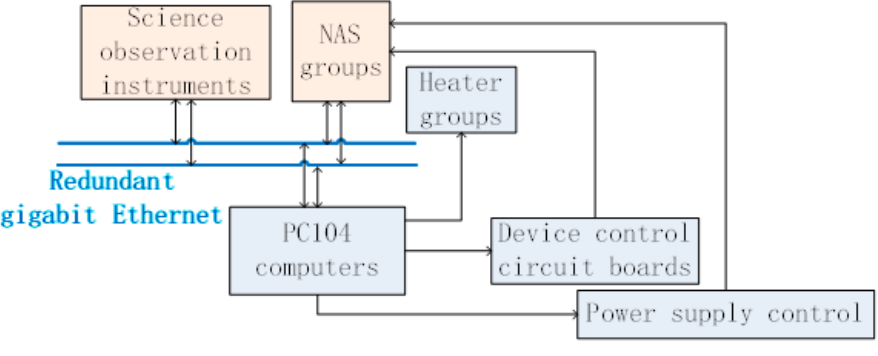
Figure 8. Mass storage control system.